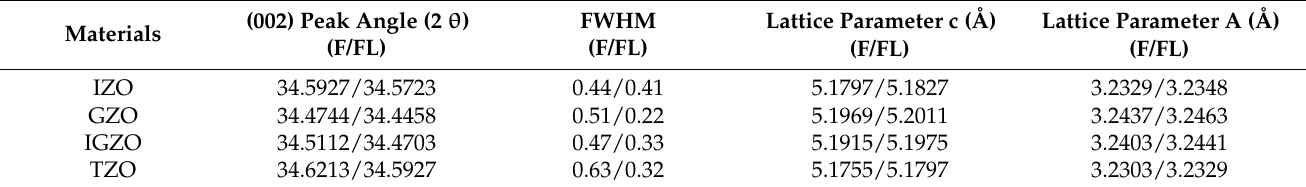
Figure 2. X-ray diffraction patterns of ZnO-based thin films after electrical furnace ( a ) and furnace & CO 2 laser annealing in four type; ( a ) Type 1: IZO, ( b ) Type 2: GZO, ( c ) Type 3 (IGZO), ( d ) Type 4 (TZO).; Scan speed: 3.0 deg/min; measuring range: 30–40 degrees; furnace: 650 °C; CO 2 laser: 1.5 W, 2.5 s. Table 1. (002) peak angle, FWHM, lattice parameter c, and lattice parameter a for the ZnO- based thin films with 2 different annealing processes; F: electrical furnace annealing, FL: electrical furnace + carbon-dioxide laser